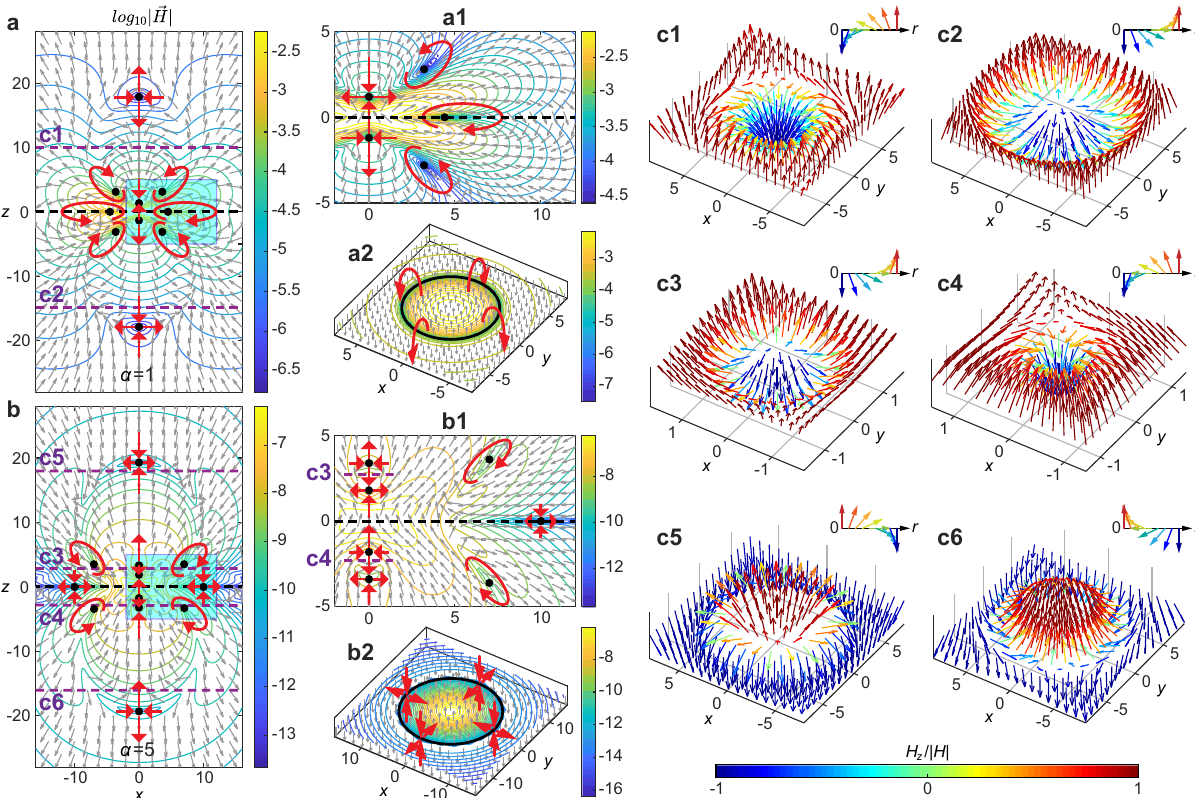
Fig. 3 Magnetic fi elds of toroidal and supertoroidal light pulses. a , b Isoline and arrow plots of the magnetic fi elds in the x – z plane for a the fundamental TLP and b the STLP of α = 5, in logarithmic scale. Magnetic fi eld singularities are marked by black dots with red arrows correspondingly marking the saddle or vortex style of the vector singularities. Panels a1 and b1 present the zoom-in plots corresponding to regions of blue boxes in ( a ) and ( b ), respectively. Panels a2 and b2 present transverse distributions of magnetic amplitude (in logarithmic scale) and normalized magnetic vectors at z = 0 planes, the positions marked by the black dashed lines in ( a ) and ( b ), respectively, where the magnetic fi elds vanish along the circular solid black lines with red arrows marking the styles of singularities (vortex for a2 and saddle for b2 ). Skyrmionic structures in magnetic fi elds of toroidal and supertoroidal light pulses: c Various textures of Néel-type skyrmionic structure observed at various transverse planes (see dashed purple lines in a and b ) for the fundamental TLP ( c1 – c2 ) and the STLP of α = 5 ( c3 – c6 ), which are demonstrated by the arrows with color-labeled longitudinal component value of magnetic fi eld. The up- right insert of each panel shows the basic texture of the skyrmionic structure. Unit for coordinates: q 1 .